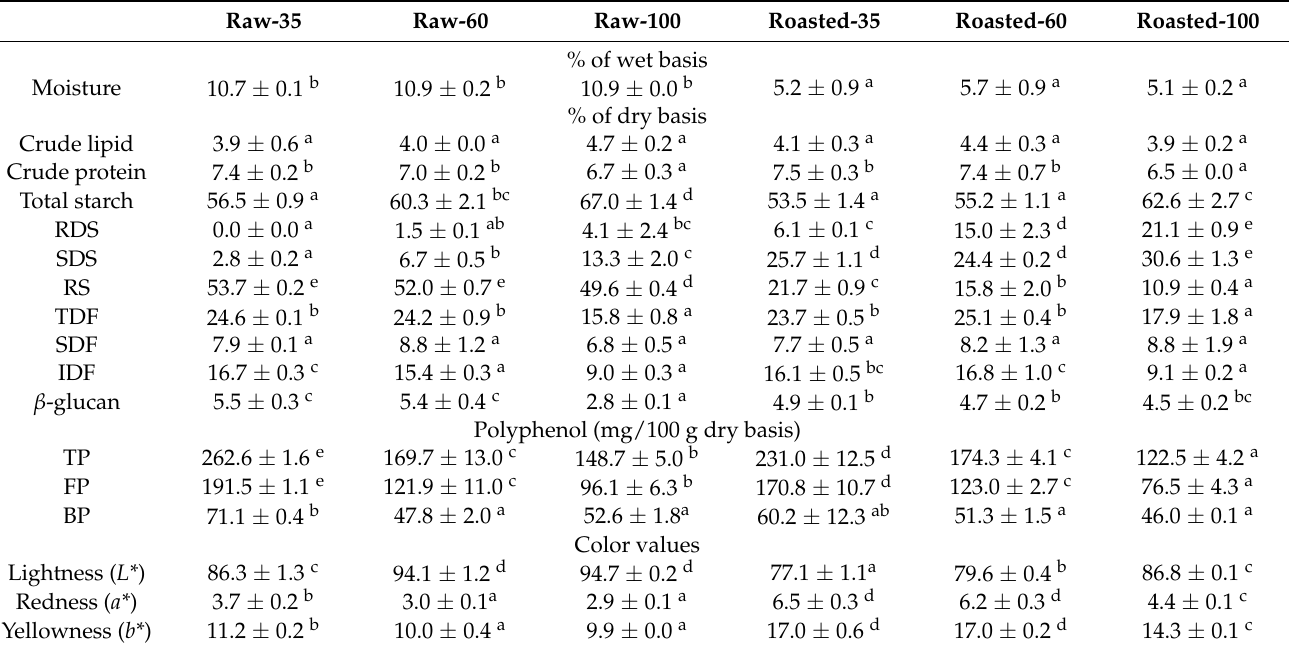
Table 1. Proximate compositions, bioactive compounds, starch fractions (RDS, SDS, and RS), and color values of raw and sand-roasted highland barley flours.